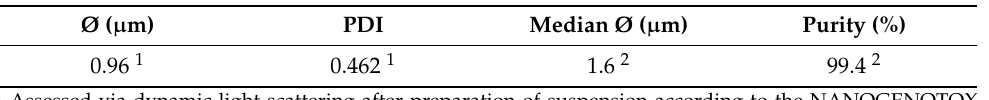
Table 1. Summary of physico-chemical properties of